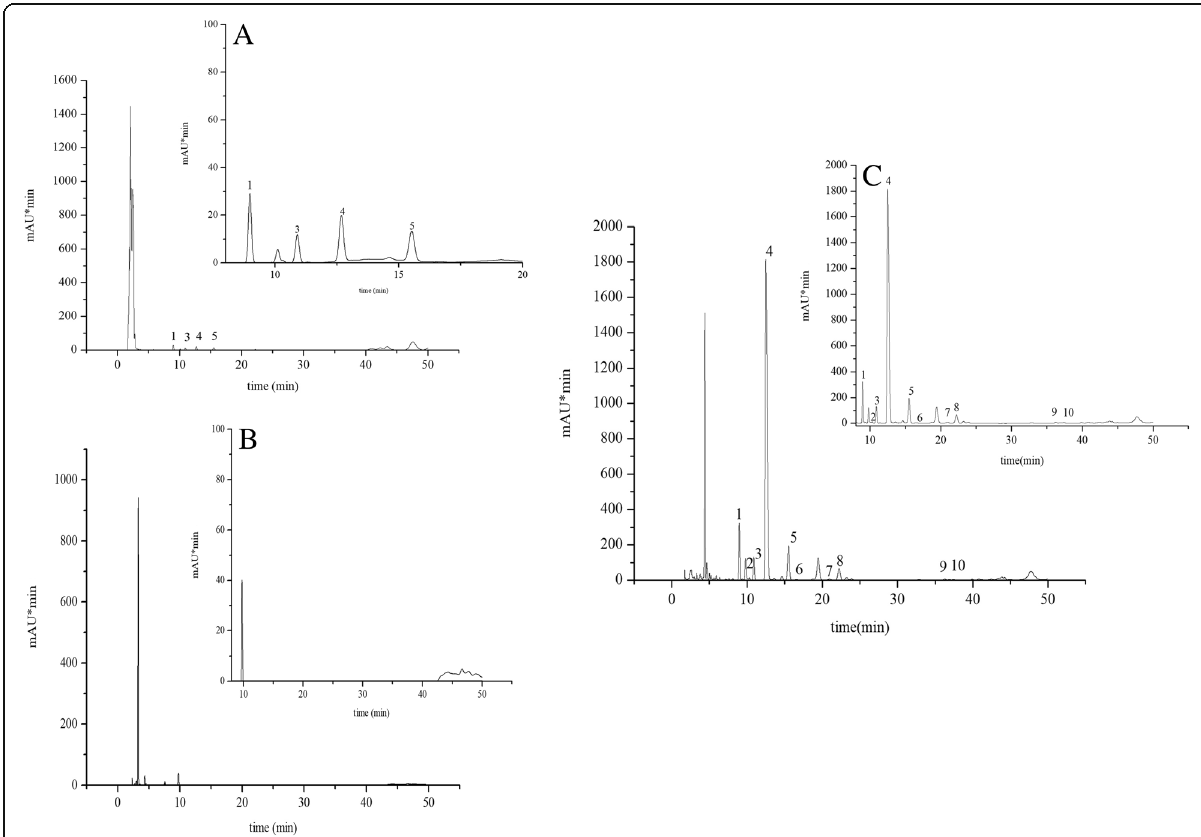
Fig. 1 HPLC chromatographs for macamides and macaene detection of a maca root extract, b Chinese chive seed extract and c combined extracts from mixture of maca root and Chinese chive seed (1:1, w/w). The components labelled are: (1) (9Z,12Z,15Z)-octadecatrienoic acid; (2) (9Z,12Z,15Z)-N-(3- methoxybenzyl) octadecatrienamide; (3) (9Z,12Z,15Z)-N-benzyloctadecatrienamide; (4) (9Z,12Z)-octadecadienamide; (5) (9Z,12Z)-N-benzyloctadecadienamide; (6) N-benzylpentadecanamide; (7) N-(3-methoxybenzyl) palmitamide; (8) N-benzylpalmitamide; (9) N-(3-methoxylbenzyl) stearamide; (10)